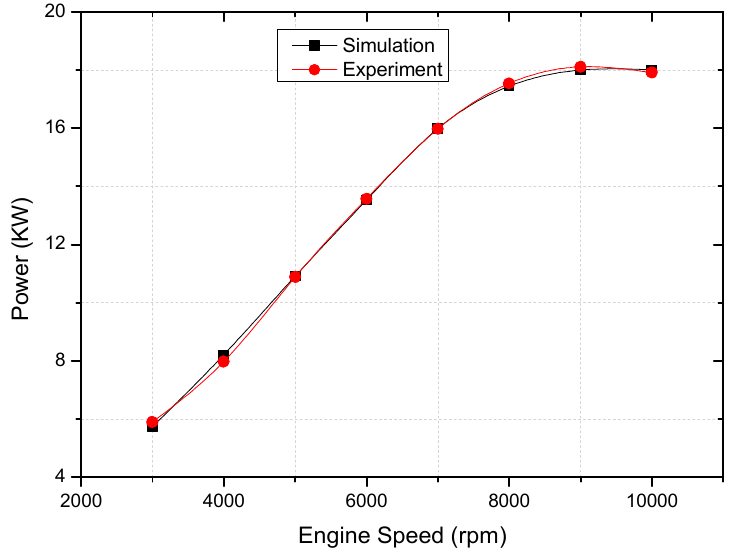
Figure 7. Engine power versus engine speed.